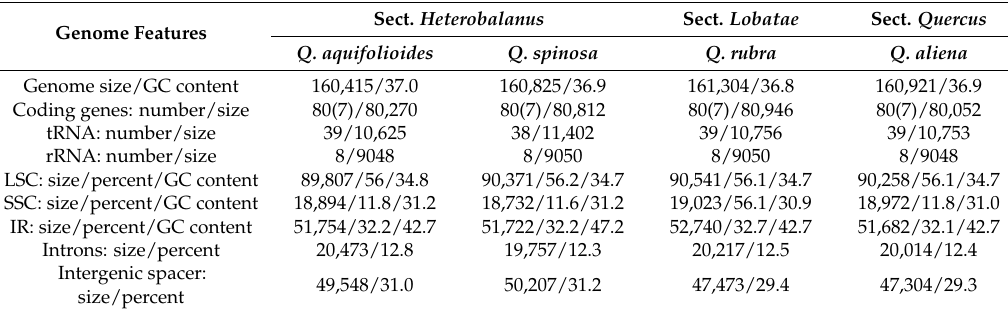
Table 1. Summary of the features of four complete Quercus